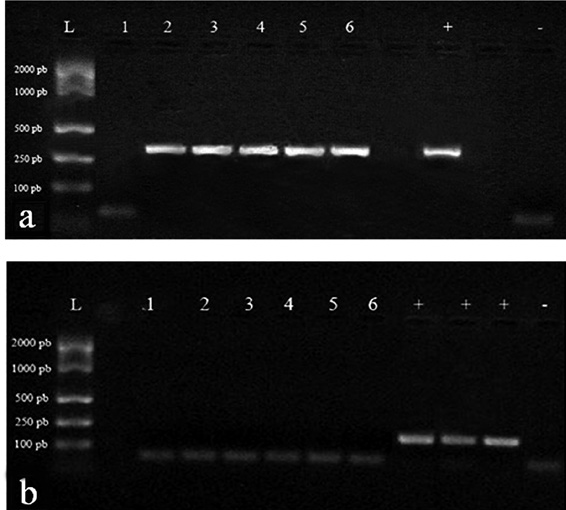
Fig. 3. – Nested PCR amplification products using an EasyLadder I - Bioline (L) for C. subsalsa and C. antiqua ( C. marina var. an- tiqua ) NIES 1: a) C. subsalsa , six replicates of 22-7-2010 (station 2) sample with five positive PCR amplifications (2-6), the positive control using CCMP217 culture (+), and the negative control (–); b) C. marina , six replicates of 22-7-2010 (station 3) sample with six negative PCR amplifications (1-6), three replicates of C. antiqua ( C. marina var. antiqua ) NIES 1 culture as positive controls (+), and the negative control